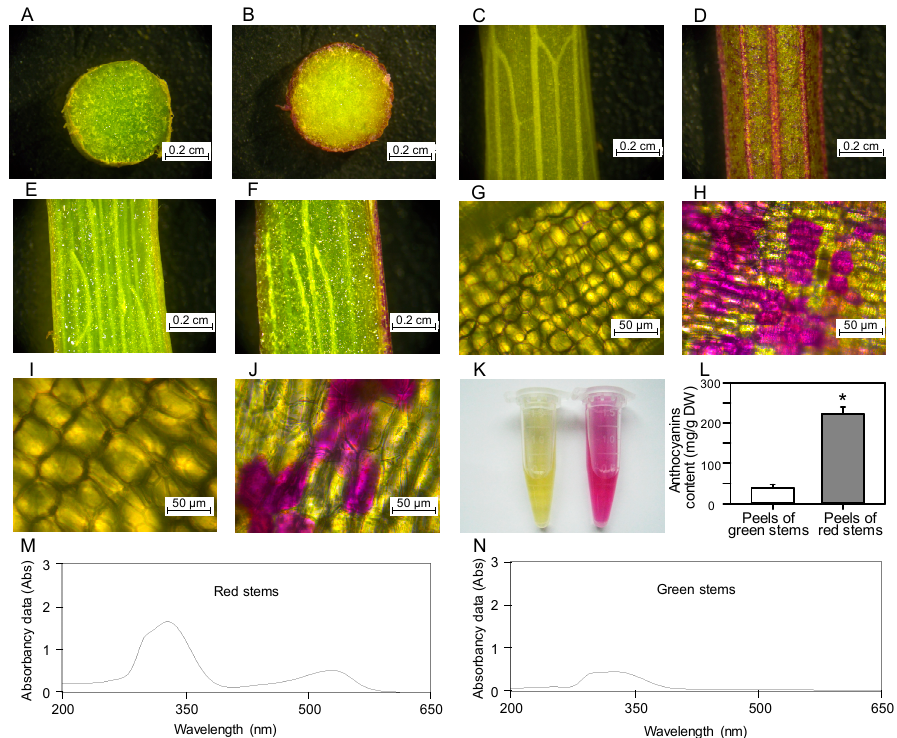
2.3. The Red Color of Stem Peels Is Mainly Localized in Epidermal Cells To further understand the function of different pigments (including anthocyanins, flavonoids, and carotenoids), the distribution of pigment-containing cells in green and red D. officinale stems was investigated (Figure 3). Red pigments (mainly anthocyanins) were only observed in the epidermal cells of red stems, but no red pigments were detected in green stems, corresponding to the visual phenotype of D. officinale stems (Figure 2). This is also related to the relatively high anthocyanin content in the peels of red stems (222.3 mg/g DW). Carotenoids might play a greater role than flavonoids in producing yellow color in D. officinale stems, even though carotenoid content was much lower than flavonoid content (Figure 2). The rationale is based on studies that have demonstrated that carotenoids play a major role in contributing a yellow color among a wider range of vegetables and fruits [26]. Overall, individual epidermal cells in the outer layer of green stems are arranged loosely, while epidermal cells in the outer layer of red stems are aligned tightly, and the intercellular space is small (Figure 3G,H). Furthermore, red pigmented cells showed a dot-like pattern, as seen for the epidermis of red stems (Figure 3J), but this phenomenon could not be observed in epidermal cells of green stems. After the epidermis was peeled off from green and red stems, it was found that anthocyanin content was significantly higher in the peels of red stems (222.3 mg/g DW) than in the peels of green stems (38.7 mg/g DW). The presence of pink/magenta and purple/blue in red D. officinale stems suggests that cyanidin- and delphinidin-based anthocyanins might accumulate [11]. The red D. officinale stems looked the same as red-fleshed grape berries [27], suggesting that the anthocyanin composition, including diglucosides of delphinidin, cyanidin, malvidin and peonidin, might be similar.